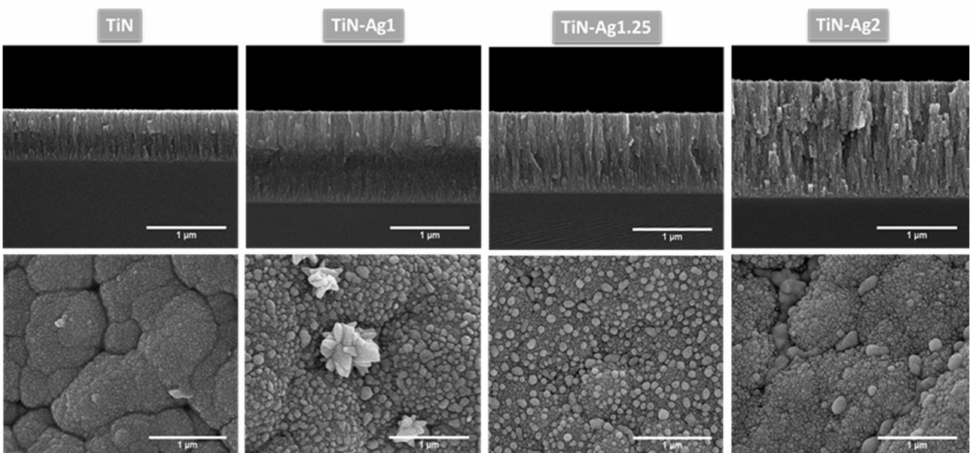
Figure 1. SEM micrographs on SE mode of different TiN-Ag thin films deposited on leather and silicon substrates with 100,000 × magnification. Images on top row are micrographs of cross-section of the different coatings deposited on Si substrates. In the bottom row are micrographs of the surface of the different coatings deposited on leather